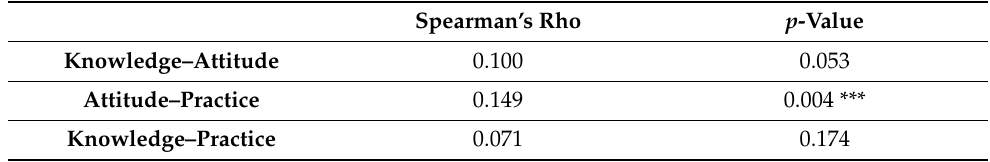
Table 5. Correlation of Knowledge, Attitude, and Practice